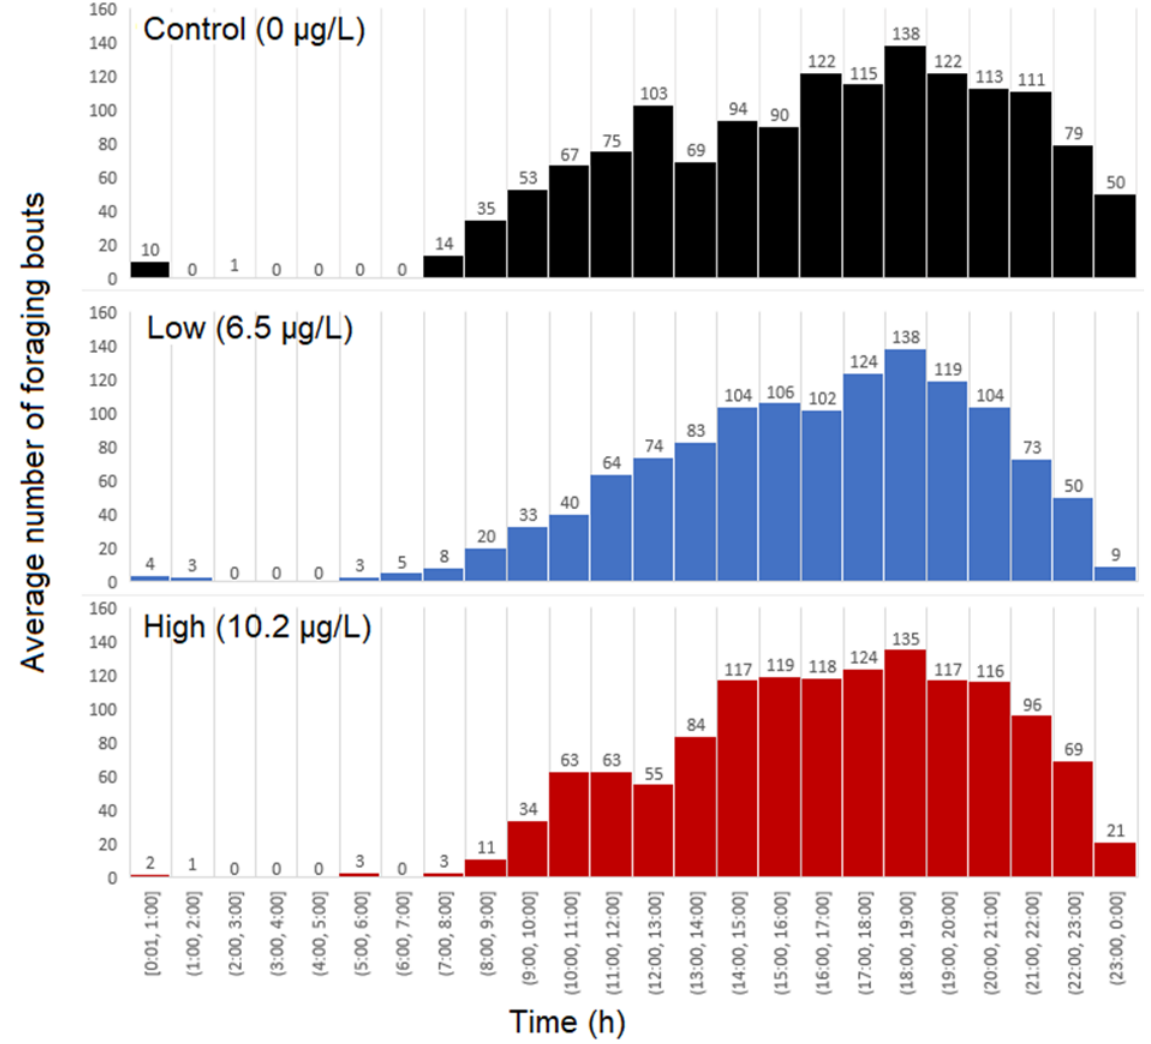
Figure 5. Histogram of the average number of foraging bouts per hour for the different test groups (black – control (not exposed), blue – low exposure (6.5 µg/L), red – high exposure (10.2 µg/L)). There was no significant difference between the test groups. Main activity window for the bumblebees in this study was between 07:00 and 23:00, with little to no activity during the night (00:00 to